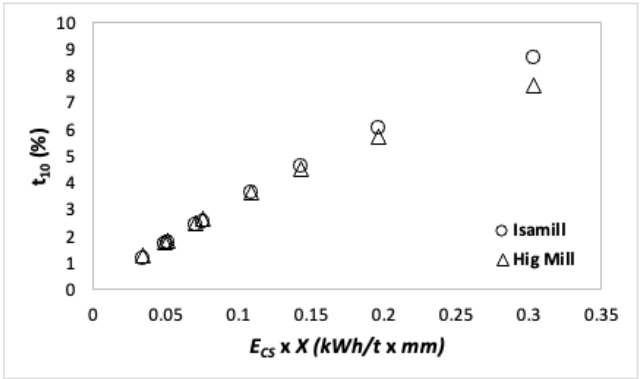
Figure 10. Size-dependent breakage model fit results.